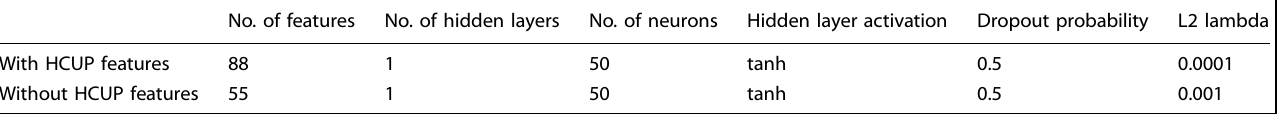
Table 2. Final model parameters for each Generalized Additive Models with Neural Networks (GAM-NNs) model with and without HCUP category description features.